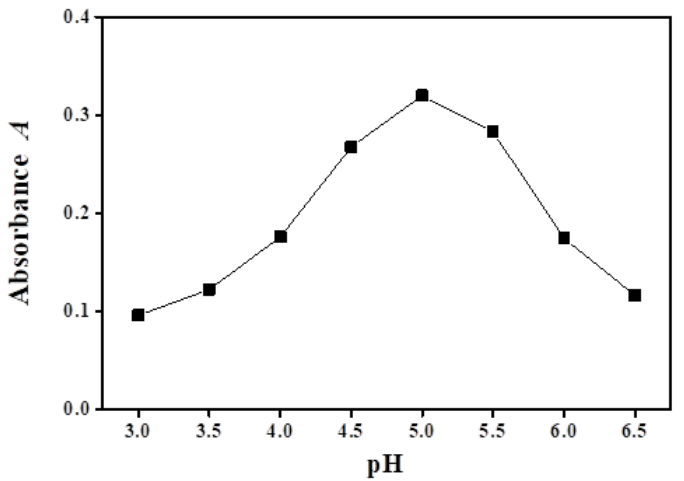
sample, 100 µ L 5 × 10 − 4 mol/L 5-Br-PADMA, 40 µ L C 6 H 5 Cl, 500 µ L CH 3 CN, and 0.5 ng Figure 6. Effect of pH on the extraction efficiency of Cu(II). Extraction conditions: 5.00 mL water sample, 100 µL 5 × 10 −4 mol/L 5-Br- PADMA, 40 µL C 6 H 5 Cl, 500 µL CH 3 CN, and 0.5 ng Cu.